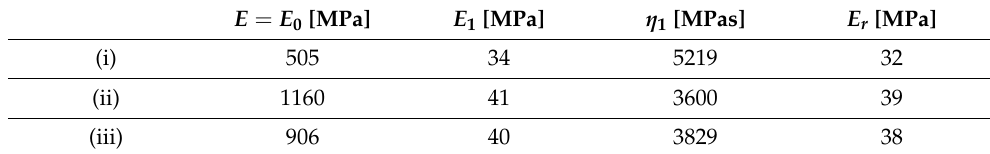
Table 3. Parameters for the standard model of mortar determined in three different